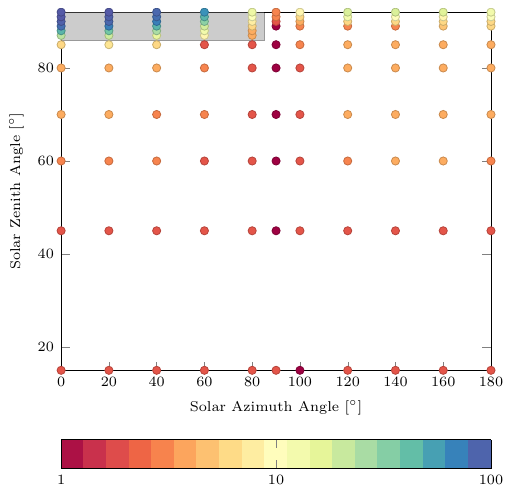
Figure 5. Number of diffuse profiles needed to get 0.2% agreement with MC, at 10km altitude and 345nm. In the shaded region the reference calculation was done using HR with 119 diffuse